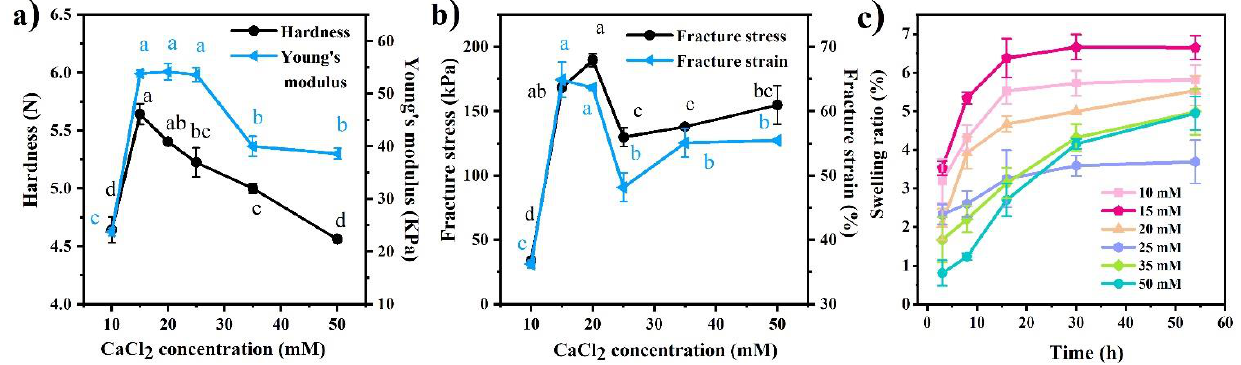
Figure 2. ( a ) Hardness and Young’s modulus, ( b ) fracture stress and strain and ( c ) swelling ratios of the heat-set whey protein gels containing different CaCl 2 concentrations. Different letters in the same curve indicate significant difference at p < 0.05.